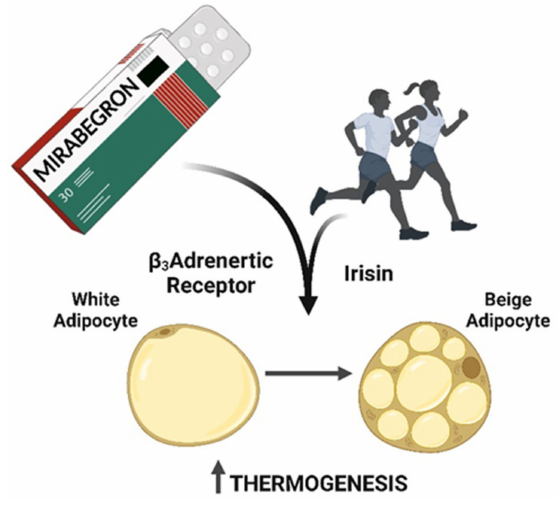
Figure 1. Mechanism of activation of browning by mirabegron and physical